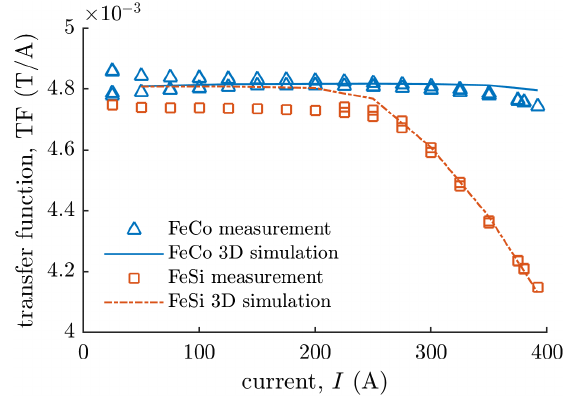
FIG. 17. Center transfer function as a function of current.